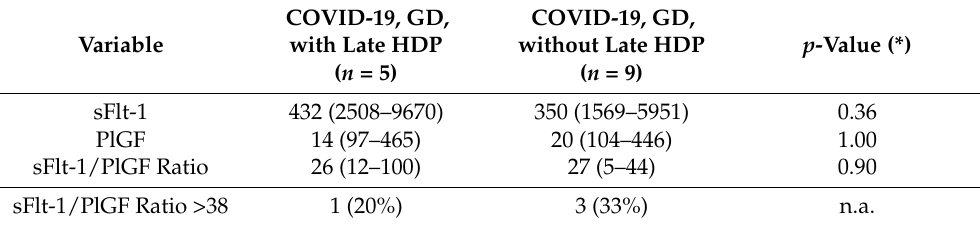
Table 4. Values of soluble blocking factor FMS-like tyrosine Kinase 1 (sFlt-1), placental growth factor (PlGF), and the sFlt-1/PlGF ratio in COVID-19 positive diabetic patients with